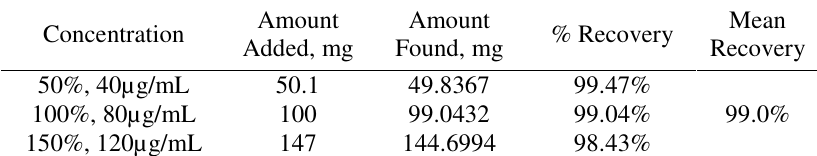
Table 5. Recovery studies of the proposed HPLC